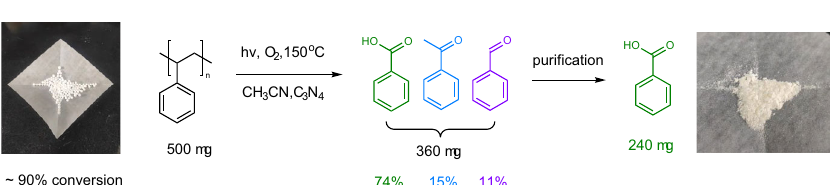
PS − 1 and PS-2 were obtainedfrom airtreatment at220°C and 300°C respectively, PS-3 was obtained from pyrolysis at 350°C in N 2 . d Selectivity and activity of polystyrene oxidation reaction at different WHSV, reaction conditions: 100mg g-C 3 N 4 , 30mL acetonitrile, irradiated by 300W Xenon lamp at 120°C, polystyrene solution (~0.3mg/mL in acetonitrile) was pumped into the reactor by a high- pressure syringe pump at different rate, 10mL reaction solution was drained out manuallywhenthePSsolutionpumpedinreachedthesamevolume.Theerrorbars represent the standard deviation of conversion in 3 parallel experiments. Source data are provided as a Source Data fi